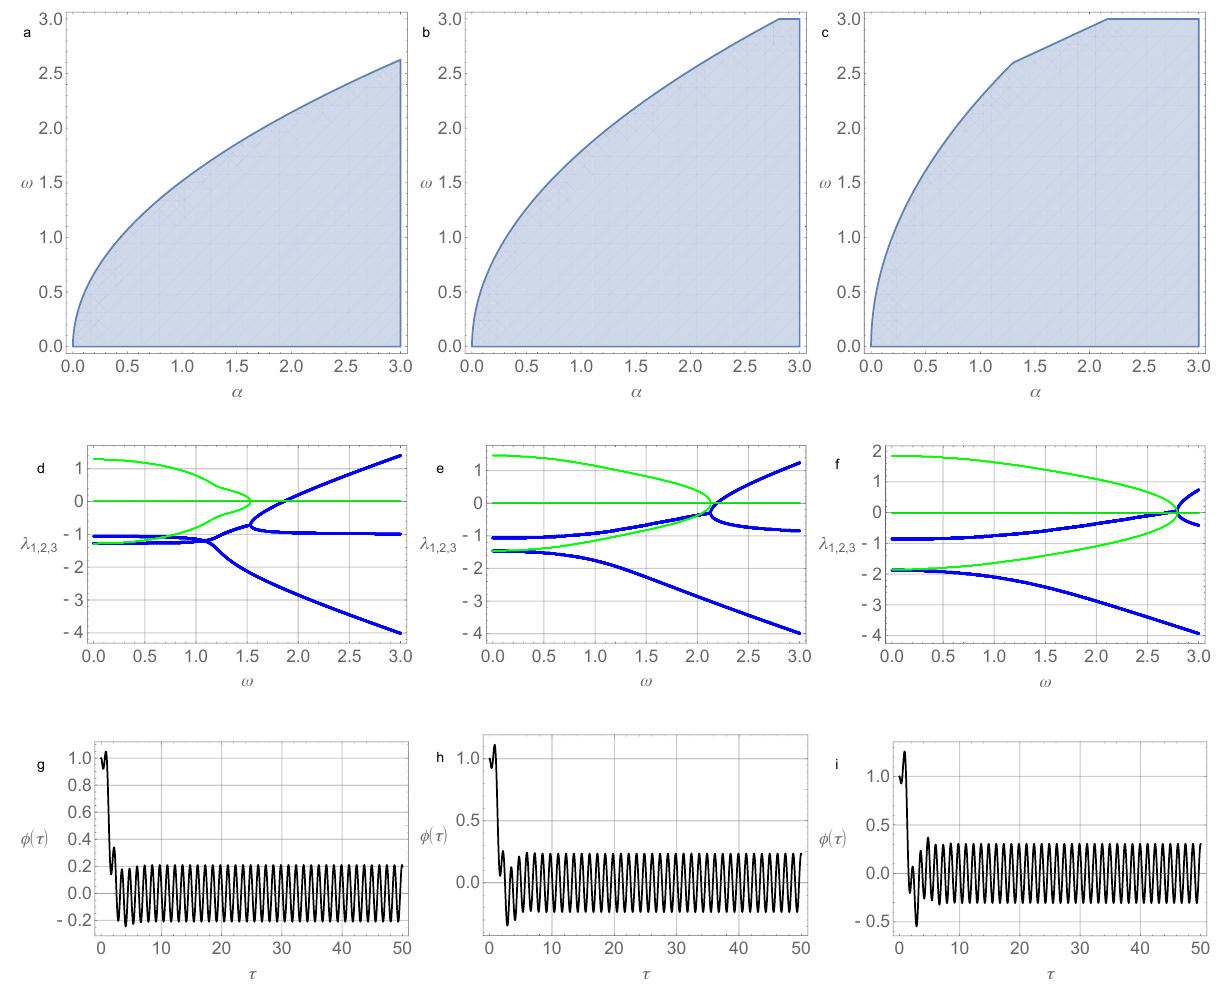
Figure 3. ( a ) System stability area (24) in the ( α , ω ) plane for parameter values σ = 0.05 and γ = 1.1; ( b ) system stability area (24) for parameter values σ = 0.5 and γ = 1.1; ( c ) system stability area (24) for parameter values σ = 1.5 and γ = 1.1; ( d ) real (thick blue lines) and imaginary parts (thin green lines) of the roots of the characteristic Equation (25) for σ = 0.05, γ = 1.1, and α = 1.5; ( e ) real (thick blue lines) and imaginary parts (thin green lines) of the roots of the characteristic Equation (25) for σ = 0.5, γ = 1.1, and α = 1.5; ( f ) real (thick blue lines) and imaginary parts (thin green lines) of the roots of the characteristic Equation (25) for σ = 1.5, γ = 1.1, and α = 1.5; ( g ) the angle of pendulum deviation depending on the dimensionless time for σ = 0.05, γ = 1.1, α = 1.5, ω = 1.2, d = 1.0, and Ω = 5.0; ( h ) the angle of pendulum deviation depending on the dimensionless time for σ = 0.5, γ = 1.1, α = 1.5, ω = 1.2, d = 1.0, and Ω = 5.0; ( i ) the angle of pendulum deviation depending on the dimensionless time for σ = 1.5, γ = 1.1, α = 1.5, ω = 1.2, d = 1.0, and Ω = 5.0. Initial conditions in ( g , h , i ) are ϕ ( 0 ) = 1.0, ψ ( 0 ) = 0.0, and v ( 0 ) =